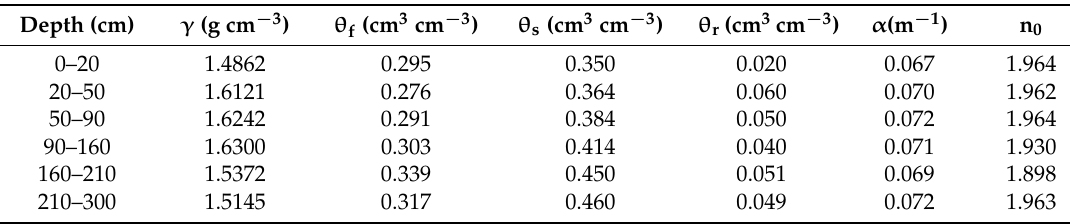
Table 2. The physical parameters of the soil.